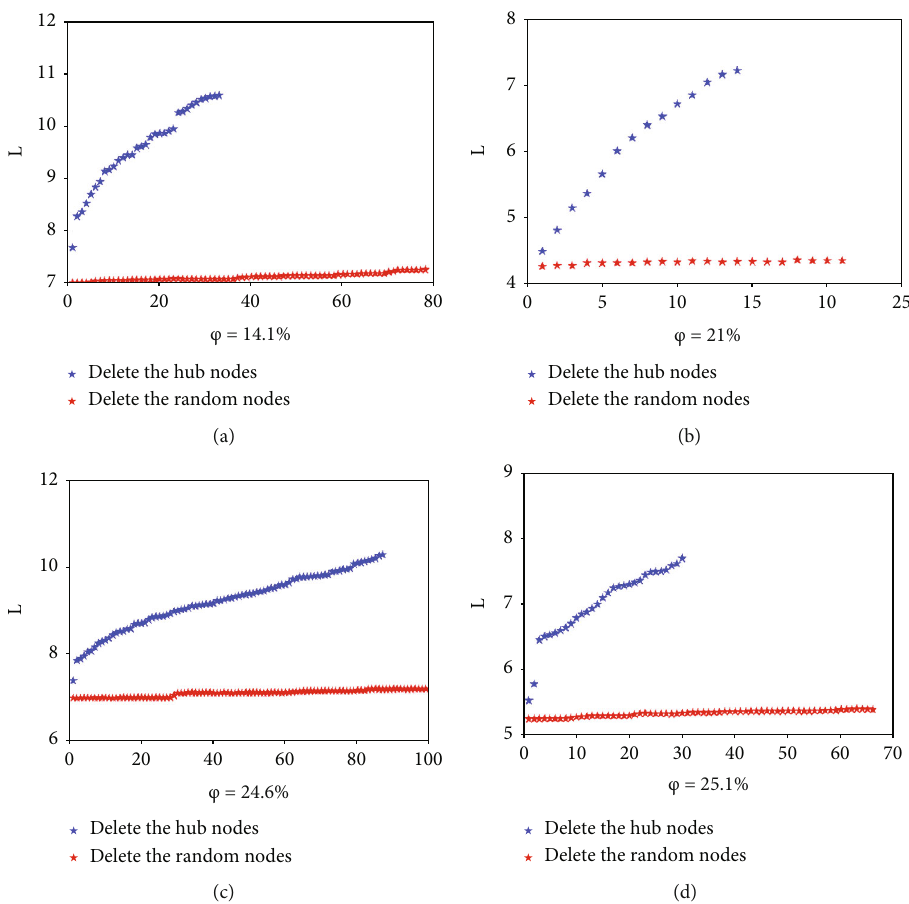
Figure 8: The alteration of the average path length of the four kinds of porosity sandstones after random nodes (nodes that are chose randomly) and hub nodes are removed